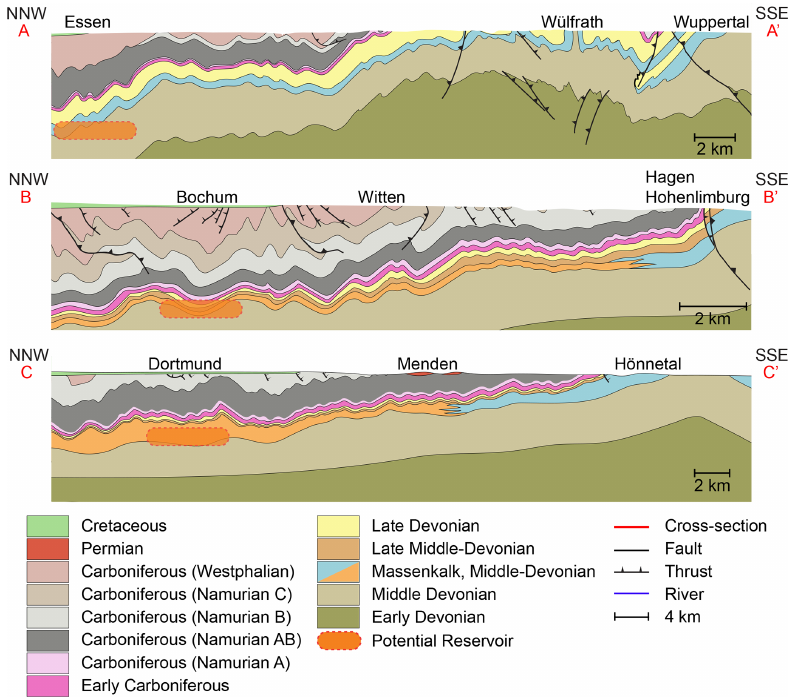
Figure 2. Simplified cross sections of the Remscheid-Altena anticline (modified after Jansen et al., 1986; Drozdzewski et al., 2007). The exact position and orientation of the three cross sections is illustrated in Fig.